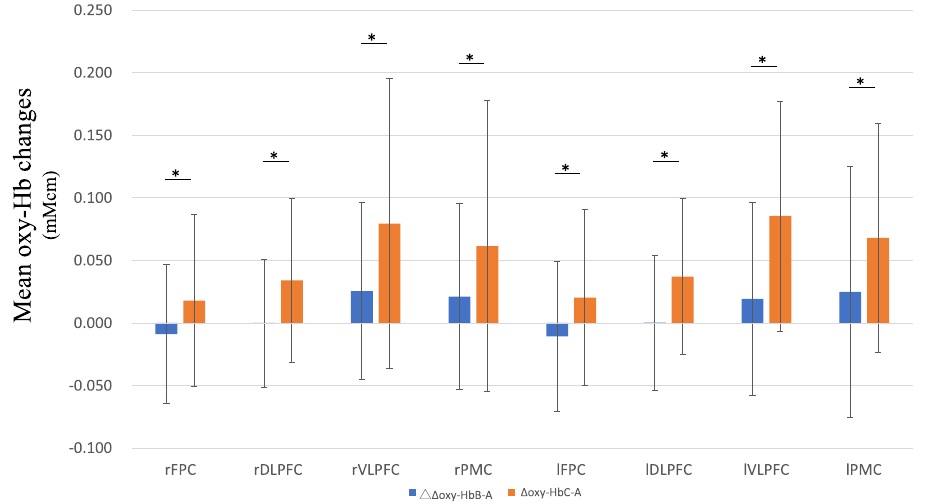
Figure 2. Mean oxygenated hemoglobin (oxy-Hb) signal changes between tasks (∆oxy-Hb B–A and ∆oxy-Hb C–A ) in each region of interest. Error bars indicate standard deviations. * p <